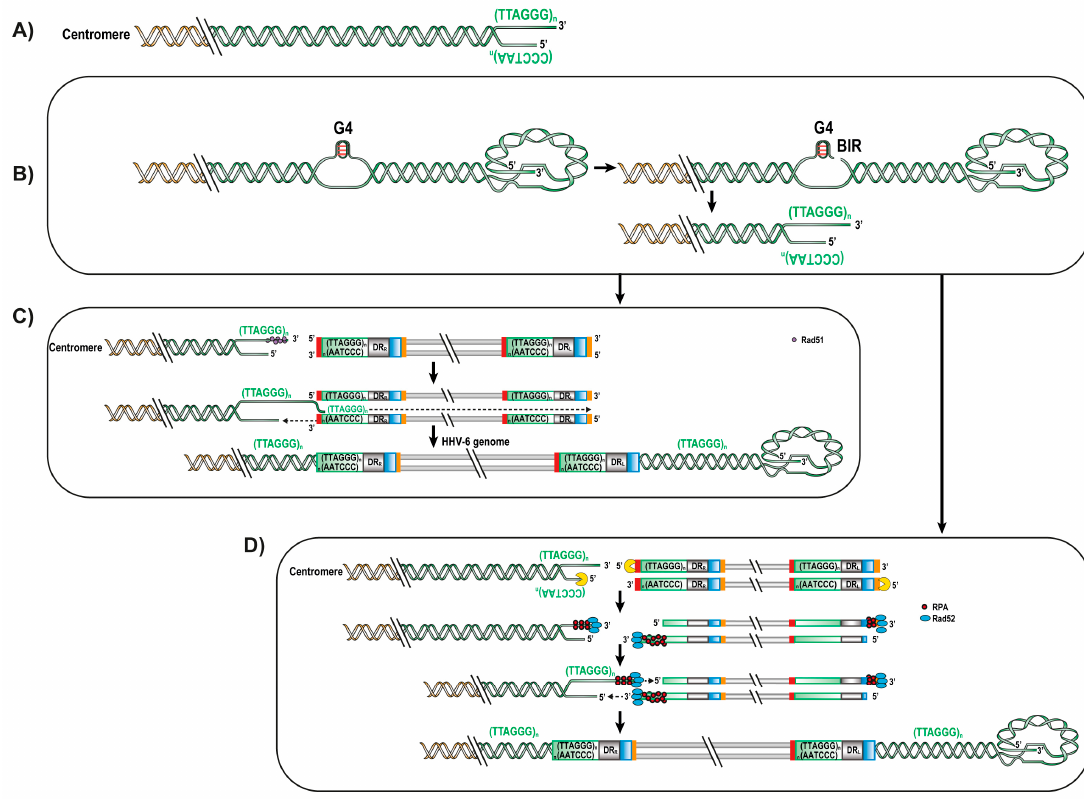
Figure 3. Possible mechanisms for HHV-6A/B integration. Schematic representation of HHV-6A/B chromosomal integration process. ( A ) Unfolding of the chromosome t-loop and invasion by the telomeric 3 (cid:48) overhang into HHV-6A/B’s DR. This mechanism is unlikely to occur since all ciHHV-6A/B reported so far have lost most telomeric repeats. ( B ) Break induced replication (BIR) repair mechanism caused by G quadruplexes (G4) structure (or other blockage) in the lagging strand. ( C ) The free 3 (cid:48) strand is rescued by Rad51 protein that searches for proximal homologous sequences. If a HHV-6A/B genome is close to proximity, Rad51 invades the viral TMR, displacing one strand of the HHV-6A/B genome to allow the synthesis of the complementary strand. Upon cell divisions, the DR L would lose the pac1 due to end replication problem and the impTMR would serve as telomeric template to elongate telomeres at the end of the genome. ( D ) Single stranded annealing (SSA) repair mechanism. Upon virus entry in the cell, DNA damage response is triggered, at the same time a break caused by a stalled replication fork at the human telomeres activate SSA. SSA activation leads to resection of both the viral and human DNA in a 5 (cid:48) to 3 (cid:48) direction to create complementary sequences. Meanwhile, the 3 (cid:48) strands of both genomes are protected by the replication protein A (RPA). Rasd52 binds the RPA and searched for pairing in which pac2 will be lost. Annealed sequences then lead to the copying of the viral genome. Genomes are not drawn to